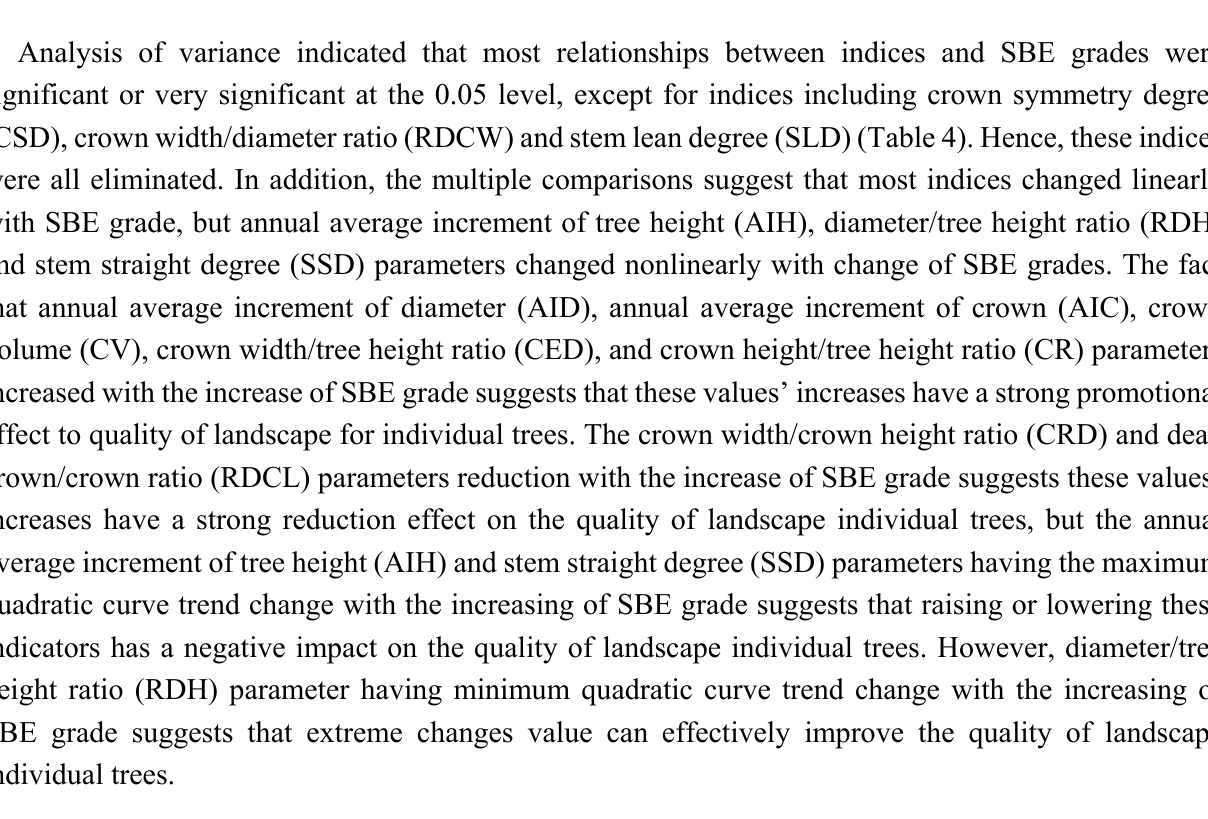
Table 4. Relationships between quality traits and scenic beauty estimation (SBE) grades for individual